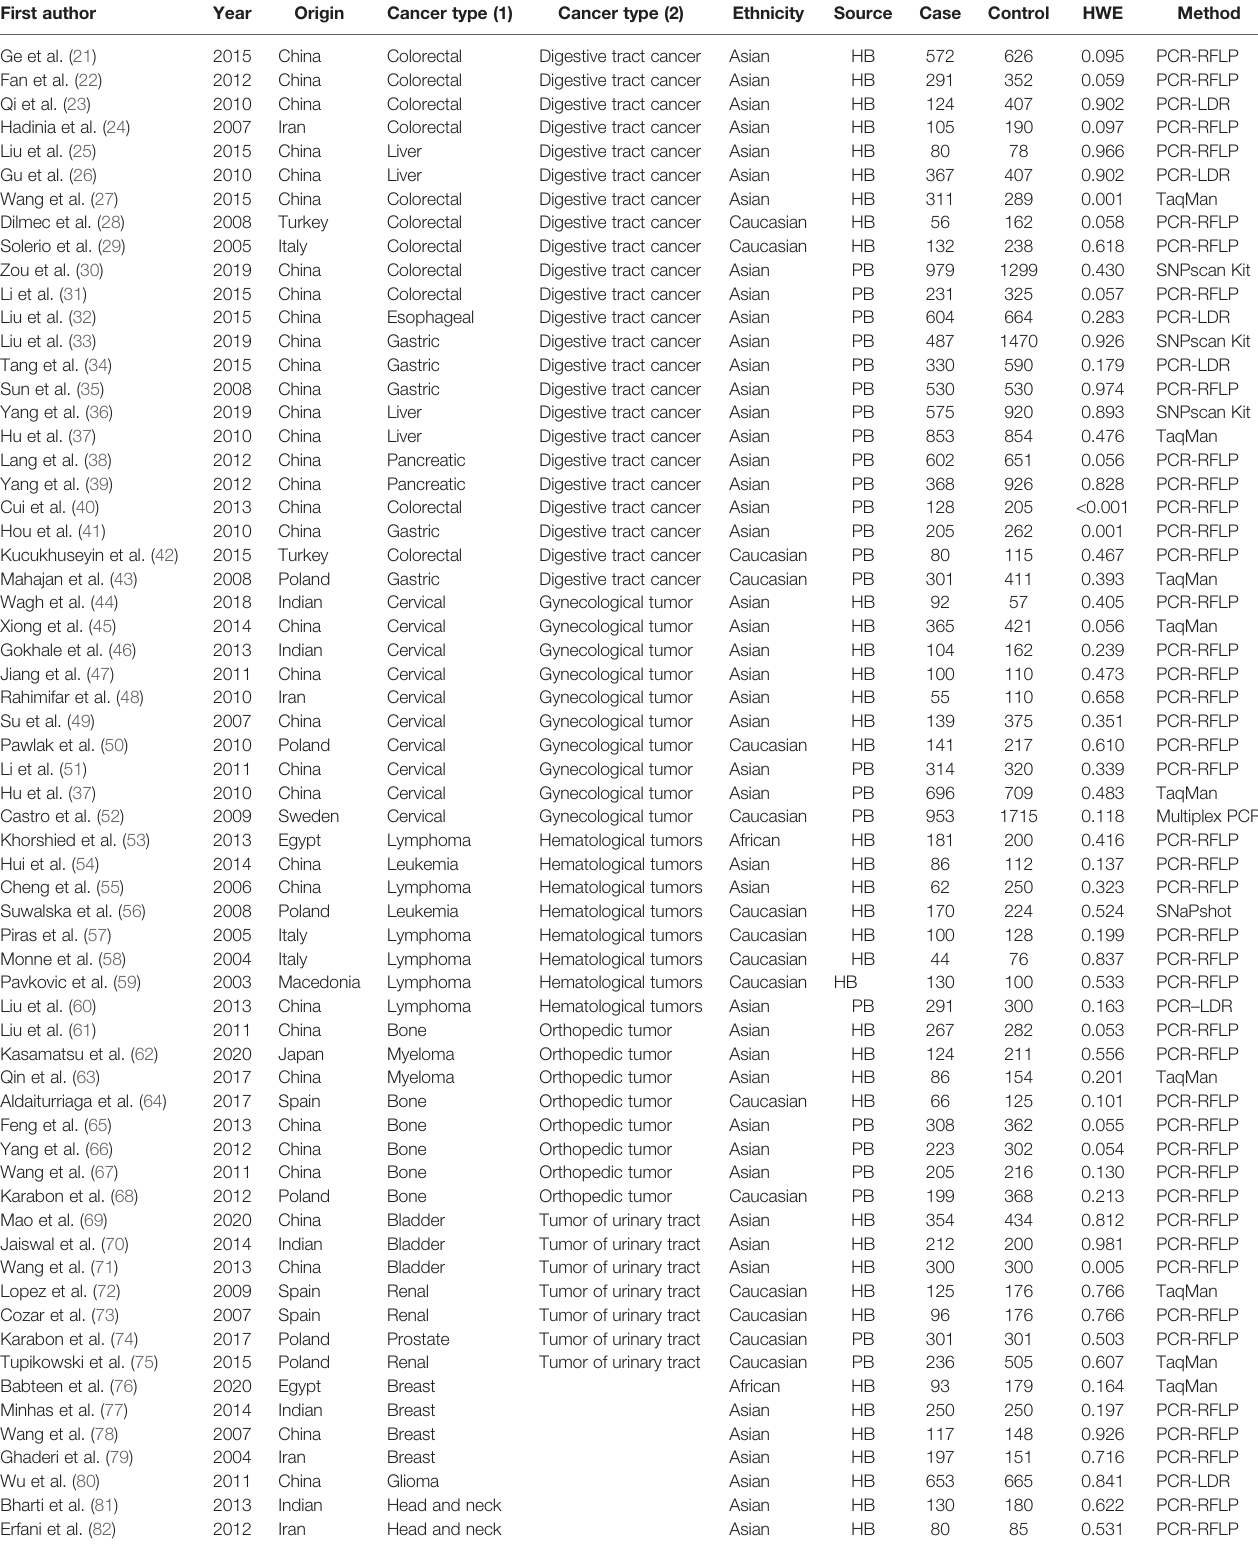
TABLE 1 | Characteristics of studies of the CTLA-4 gene rs231775 A/G polymorphism and cancer risk included in our